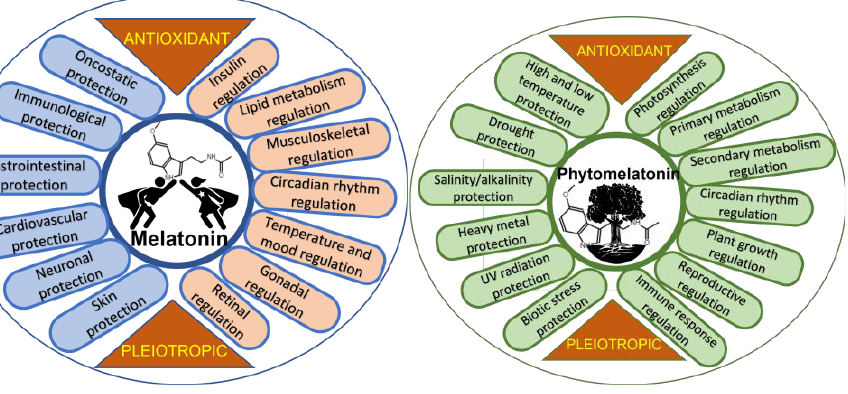
Figure 1. Diagram showing general roles of melatonin in humans and phytomelatonin in plants.